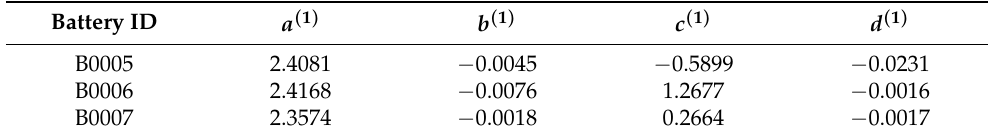
Figure 3. The relationship between the capacity and charge–discharge cycle of four lithium-ion batteries in the NASA PCoE laboratory. Table 1. The initial values of the model